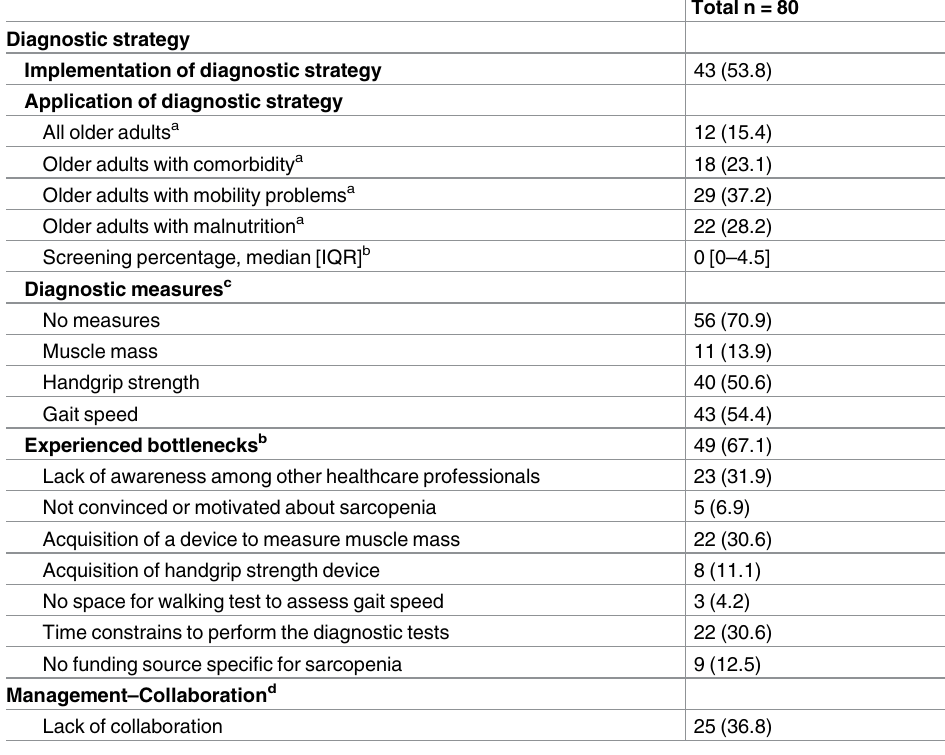
Table 3. Diagnostic strategy and management of sarcopenia of healthcare professionals five months after attendance (n =